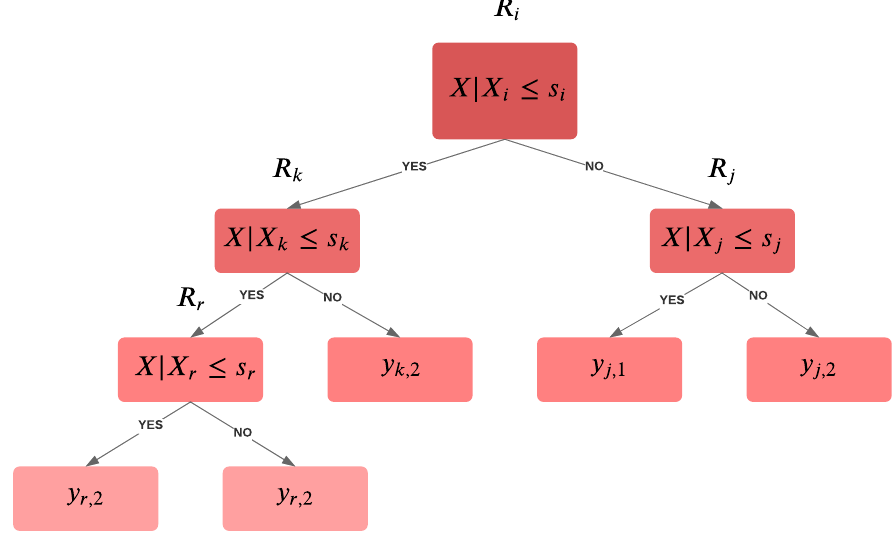
Figure 5. Simple structure of decision tree for